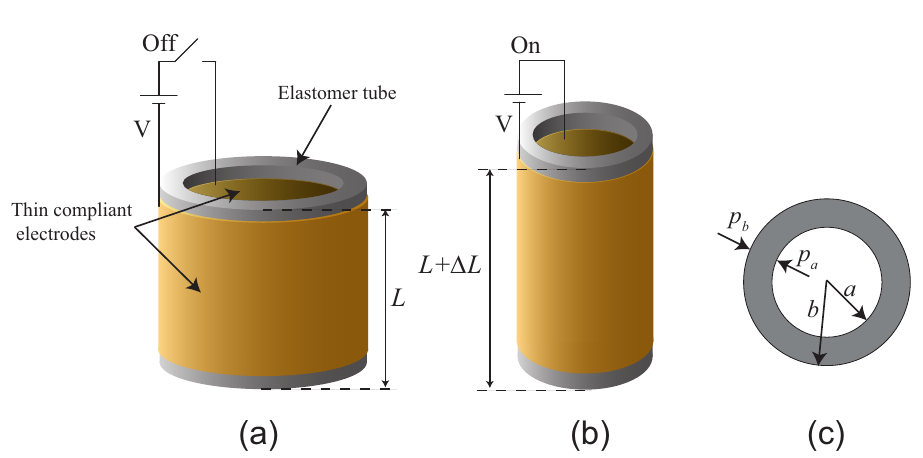
Figure 3. ( a ) Tube actuator with thin compliant electrodes on both sides of tube at its original length,